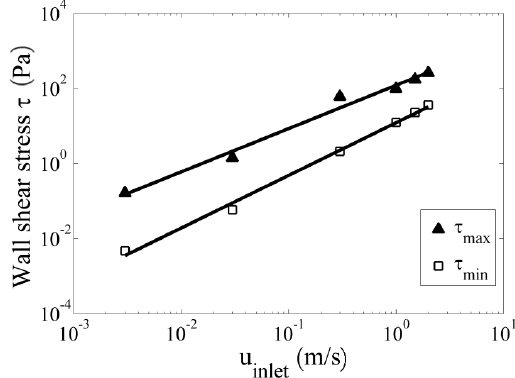
Figure 7. Maximal and minimal wall shear stress within the sensor probe in dependence of the inlet velocity 𝑢 inlet and a drop size of 150 nm.